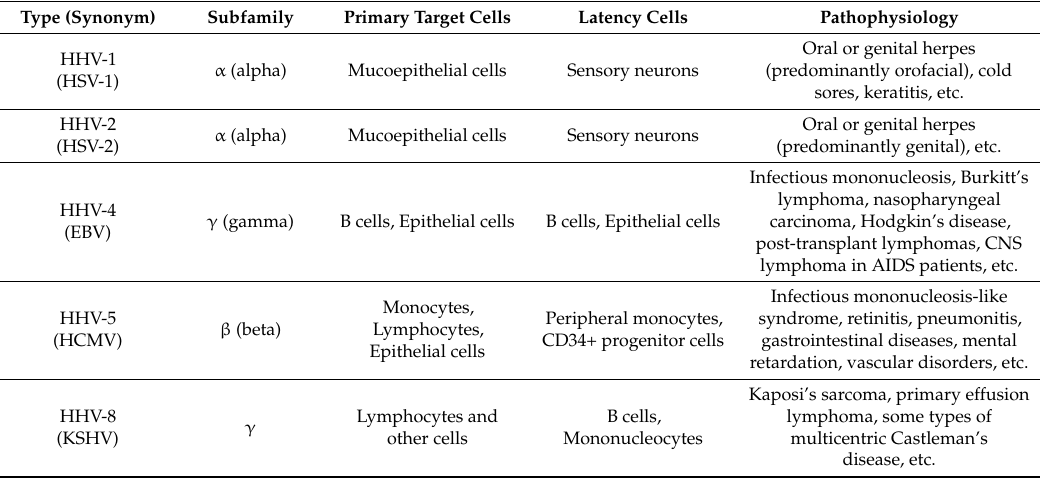
Table 1. Major human herpesviruses (HHV-1, -2, -4, -5, and